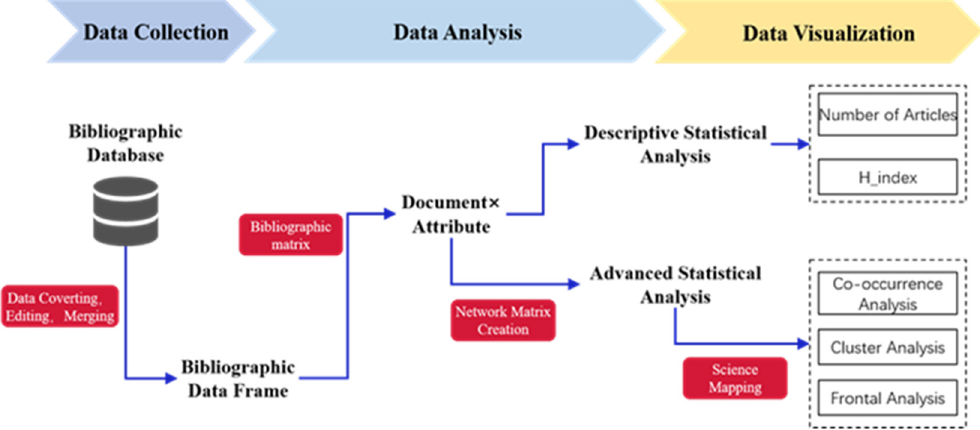
Figure 1. Bibliometrix and the recommended science-mapping workflow.